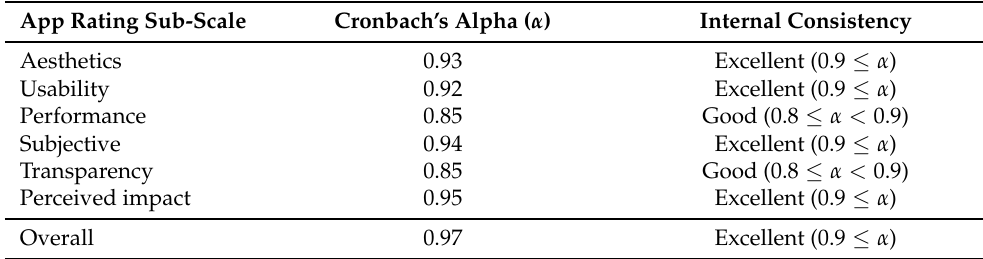
Table 3. Internal consistency of the devised app rating